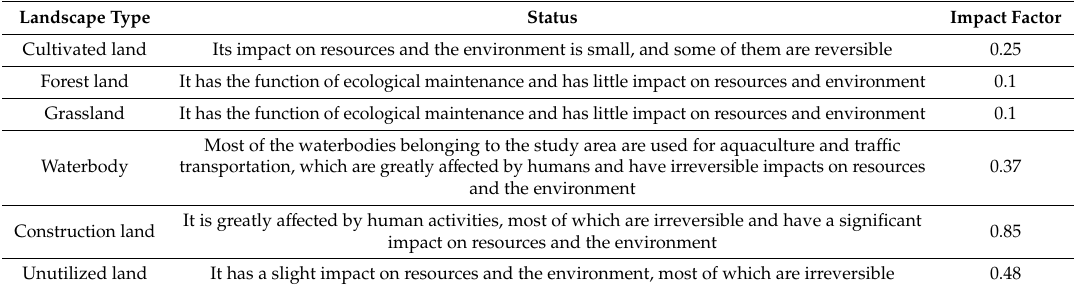
Table 1. Impact factors on landscape resources and